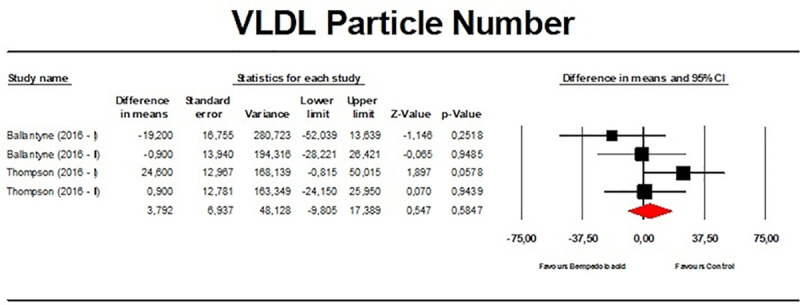
Forest plot displaying mean difference and 95% confidence intervals for the effect of bempedoic acid on plasma levels of very-low-density lipoprotein (VLDL) particle number.